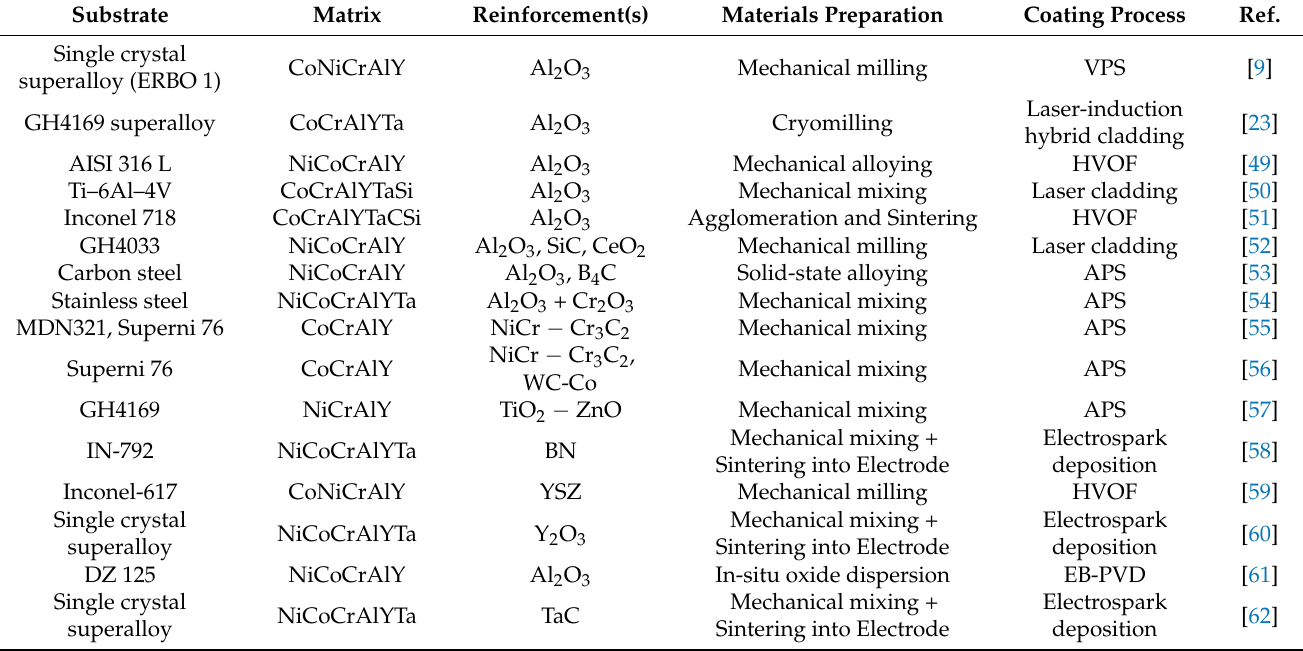
Table 2. A summary of reported studies on the dispersion-strengthened MCrAlY-based